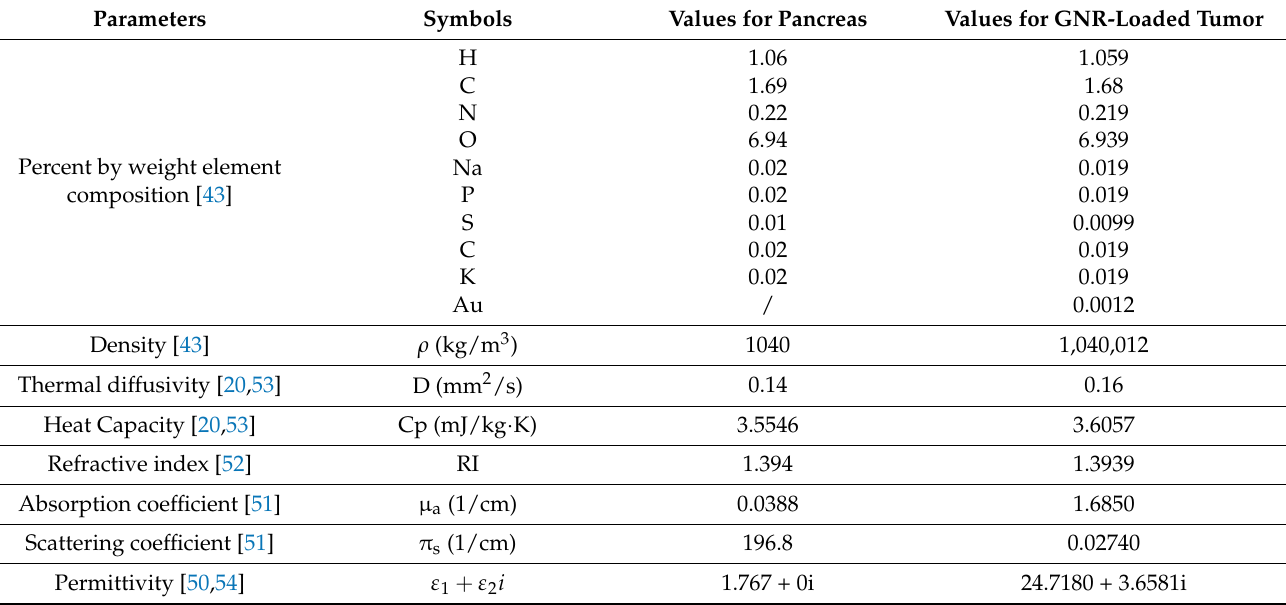
Table 1. Properties of the pancreas tissue used in our